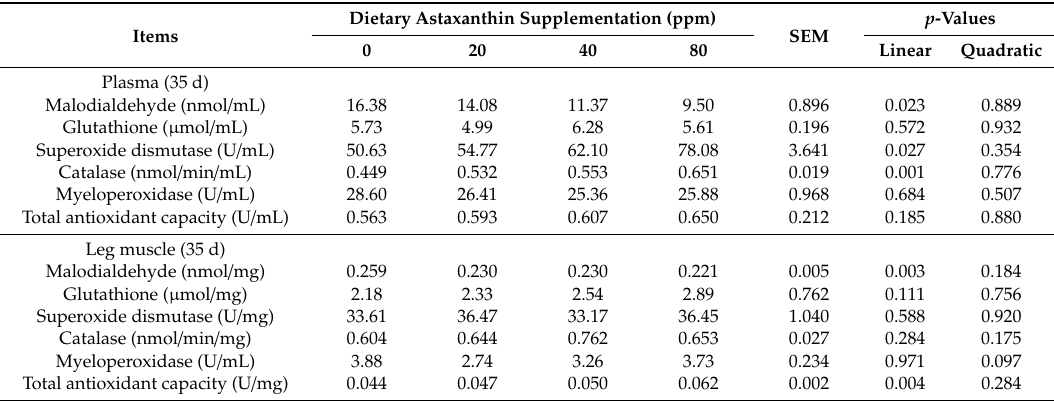
Table 2. E ff ect of dietary astaxanthin supplementation on oxidation statues in plasma and muscle of broiler under hot